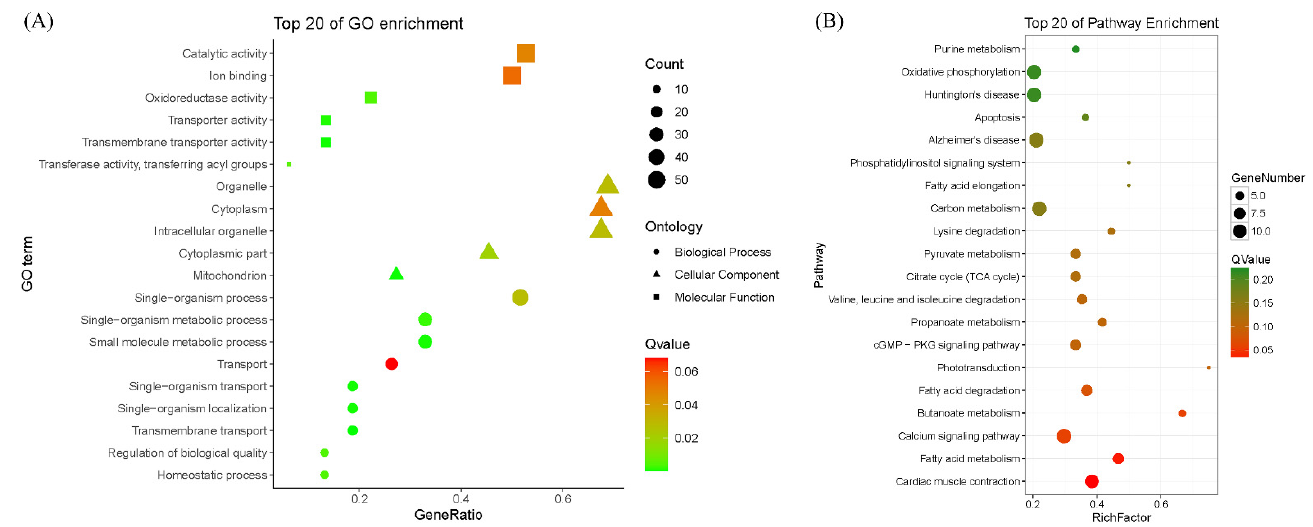
Figure 4. GO and KEGG pathway enrichment analysis of DAPs. ( A ) GO enrichment analysis of DAPs. ( B ) KEGG pathway enrichment of DAPs. The top 20 enrichment GO terms and pathways are shown, and detailed information can be found in Table S5.